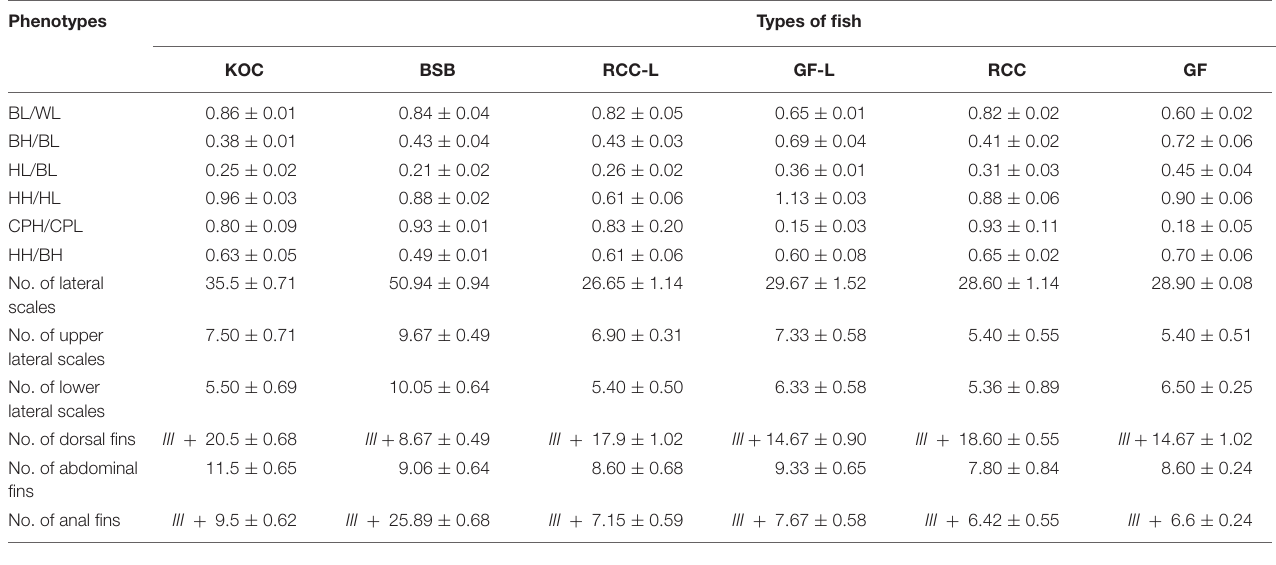
TABLE 2 | Chromosome numbers in KOC, BSB, RCC-L, GF-L, RCC, and